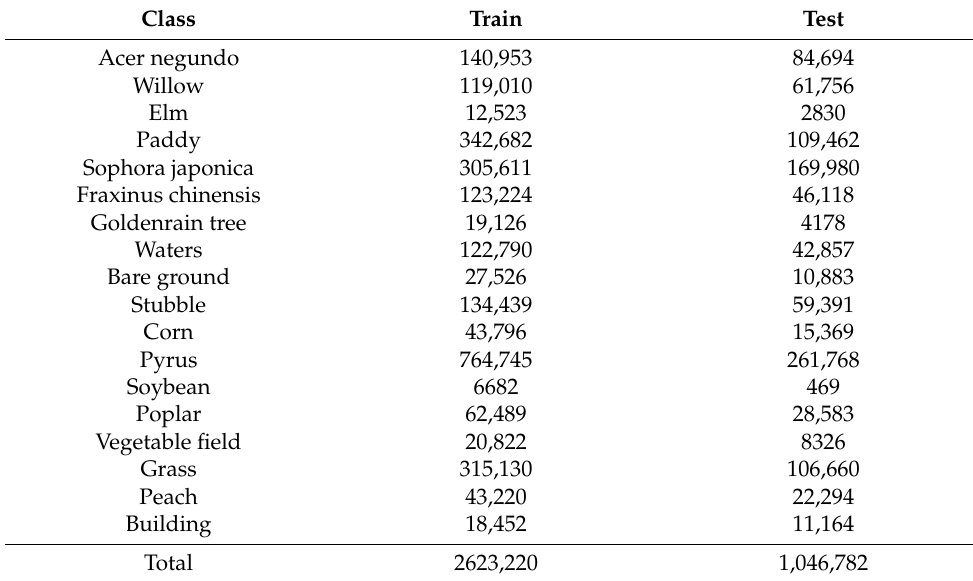
Table 3. Number of samples in train and test sets for the Xiongan